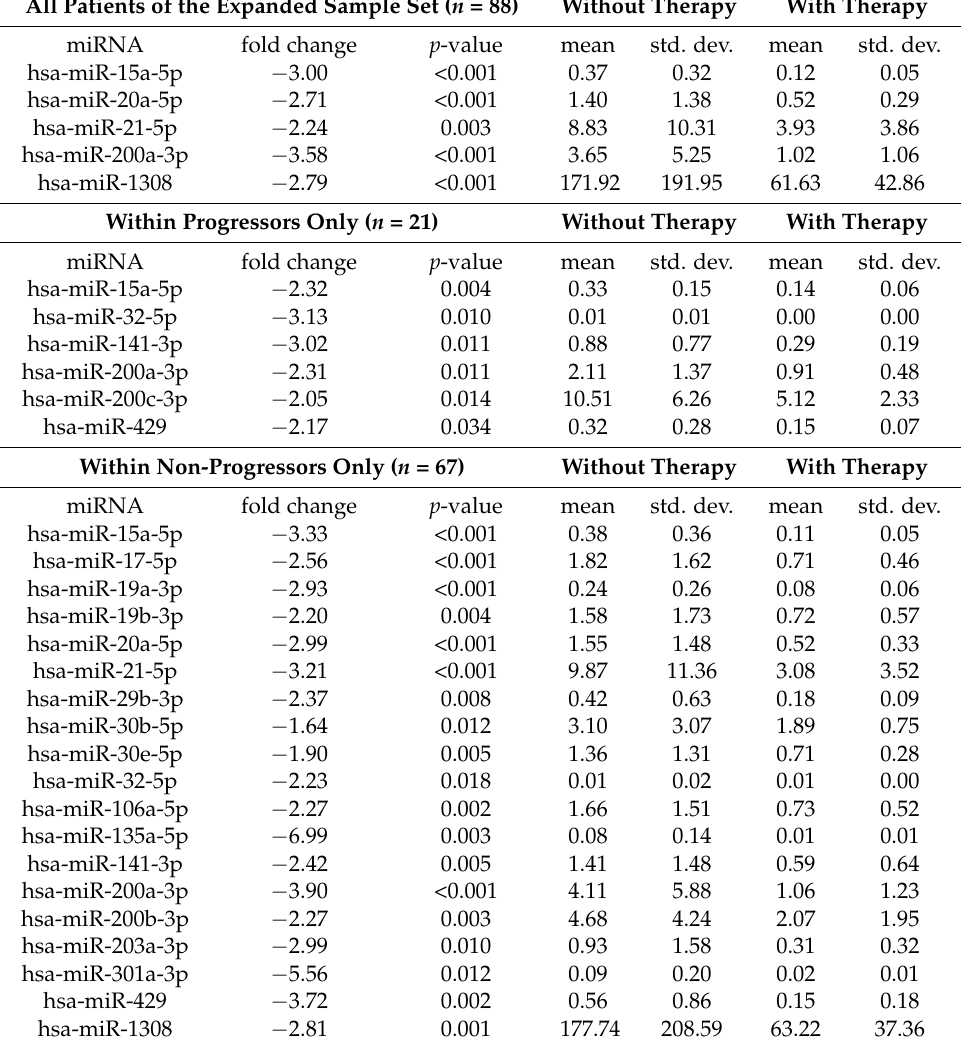
Table 3. Relative expression of miRNAs differentially expressed between patients of the expanded sample set with or without intravesical therapy. Negative fold change values indicate expression was higher in patients without therapy. Mean values are expressed as 2 − ∆ Ct . std. dev. = standard deviation. All Patients of the Expanded Sample Set ( n = 88) Without Therapy With Therapy miRNA fold change p -value mean std. dev. mean std. dev. − 3.00 <0.001